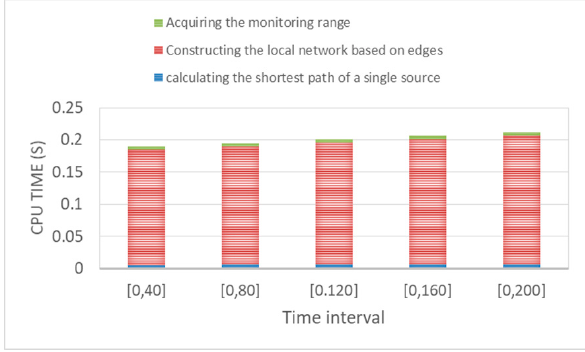
Figure 16. Time-consuming of local road network construction stage under different time interval.